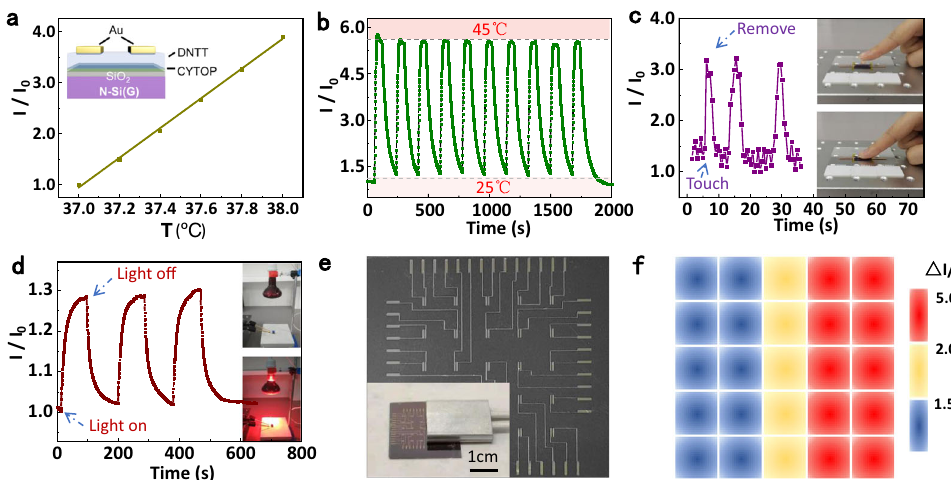
Fig. 5 Applications of the thermo-sensitive OFET for temperature sensing. a Temperature resolution curve of sensor measured at 37 – 38 °C with a precision of 0.2 °C. The inset shows the device structure. b Cyclic stability of temperature sensor from 25 °C to 45 °C. c Response of temperature sensor to fi nger touch. d Response of temperature sensor to infrared heat source. e A photo of the OFET temperature sensor array. f Temperature mapping measured by the sensor